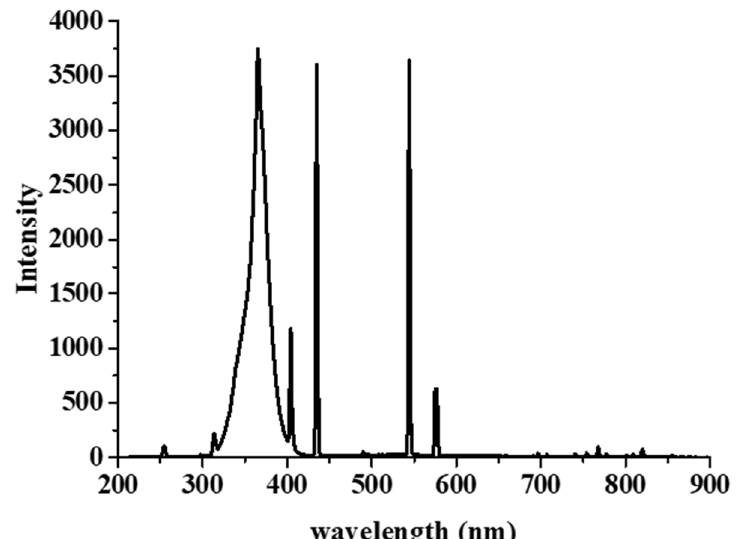
Figure 7. Emission spectrum of the used light source.